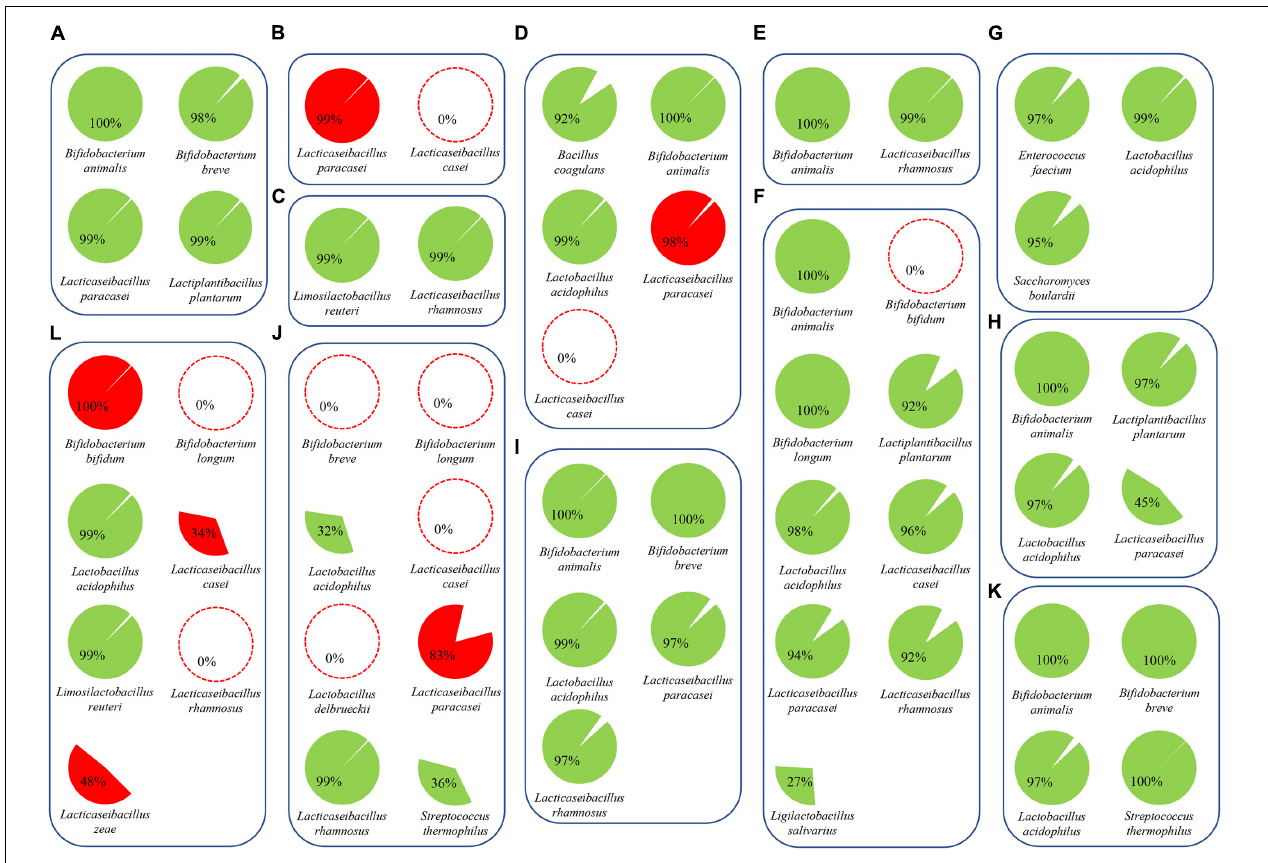
FIGURE 4 | Assembled genomes from probiotic supplements. Reconstructed microbial genomes are represented by cake diagrams arranged in boxes for each of the 12 probiotic products ( A–L ; see Table 1 ). Missing microbes are reported as red dotted circles, while bacterial genomes not declared by the producers are highlighted in red. The percentage of each cake diagram corresponds to the completeness of the reconstructed